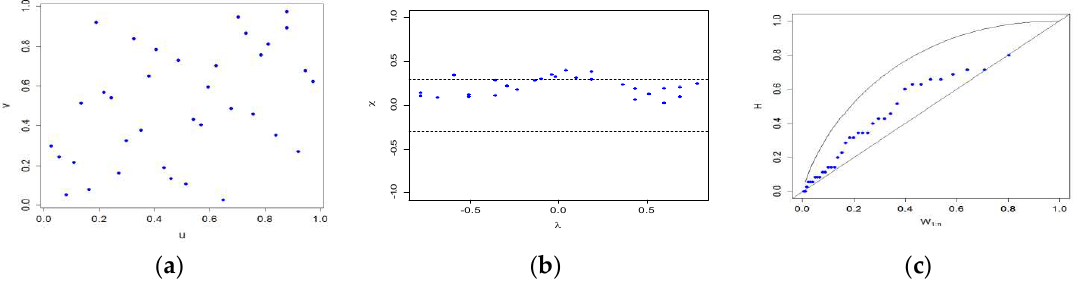
Figure 3. ( a ): Scatter plot between u and v of the peak flow and volume of Tarbela dam ( b ): Chi- plot between λ and χ of the peak flow and volume of Tarbela dam and ( c ): K-plot between W i,n and H of the peak and volume of Tarbela.